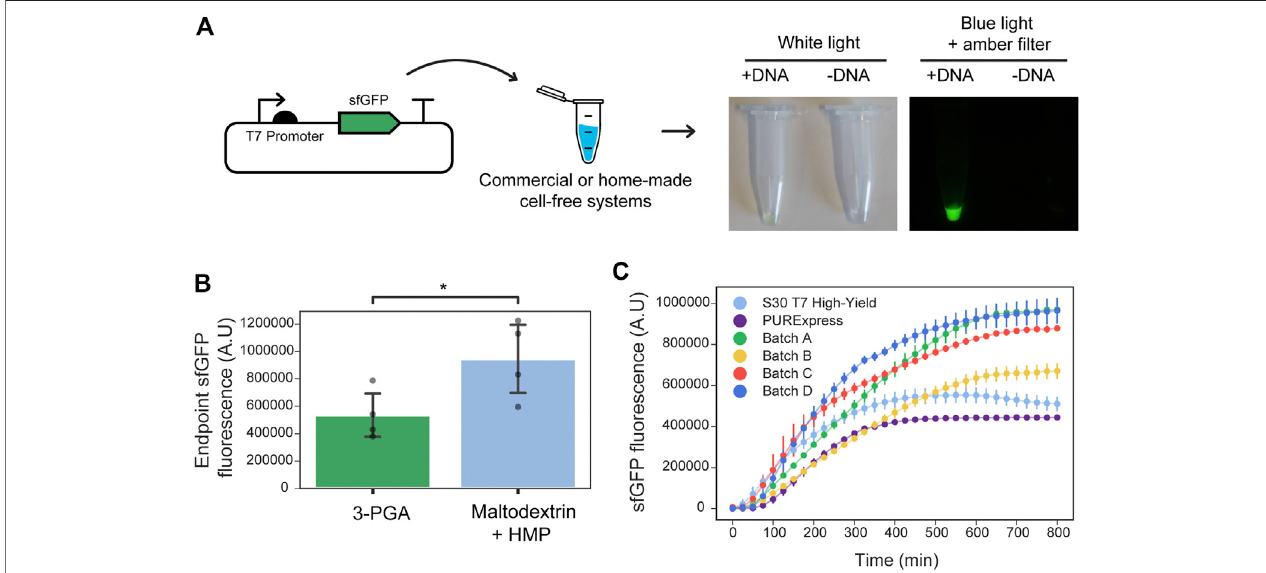
FIGURE 1 | Optimized in-house cell-free reactions compared to commercial alternatives. (A) Left: Schematic representation of testing the performance of home- madeorcommercialcell-free systemsusingthesfGFPconstitutivereporter.Right:ExampleoftheendpointsfGFPreaction andnegativecontrol(withoutinputDNA)ina home-made cell-free system supplemented with maltodextrin energy source. Tubes were photographed under white light or blue light plus an amber fi lter that allows visualizing the sfGFP fl uorescence. (B) Endpoint sfGFP fl uorescence (plasmid DNA at 9 nM fi nal concentration) was measured in four different cell extracts (Batch A, B, C, D) supplemented with either maltodextrin and polyphosphates (light blue) or 3-PGA (green) as energy source. Grey dots represent the arithmetic mean of three measurements performed on each batch, and error bars represent standard deviations of the means of the four batches tested (N (cid:1) 4). t -test for paired measurements was performed and statistically signi fi cance was found between the two groups ( p -value (cid:1) 0.03, shown by *). Assumptions of the paired t -test were veri fi ed using the Shapiro-Wilk test for normality of the differences between energy sources for a given batch ( p -value (cid:1) 0.97), and Levene test for homoscedasticity of the 3-PGA and maltodextrin data sets ( p -value (cid:1) 0.25). (C) sfGFP production dynamics from plasmid DNA (9 nM fi nal concentration) in reactions performed at 29 ° C using NEB PURExpress and Promega S30 T7 High Yield commercial kits along with four optimized in-house cell-free reactions (Batch A, B, C, D) using maltodextrin and polyphosphates as the energy source. Error bars represent the standard deviations of three independent replicates, dots are centered at the arithmetic mean for each time